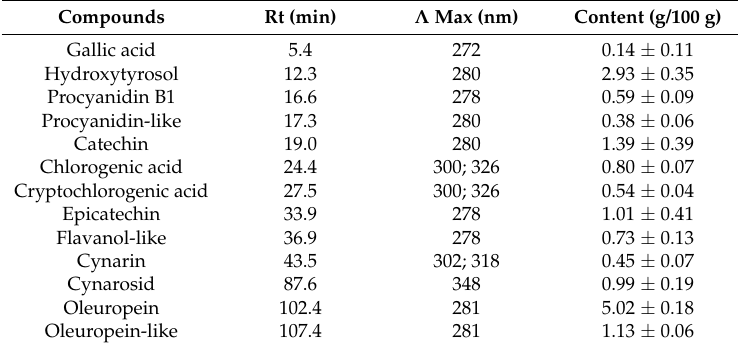
Table 2. Characterization of the phenolic compounds identified in the Oleactiv ® supplement. Rt, retention